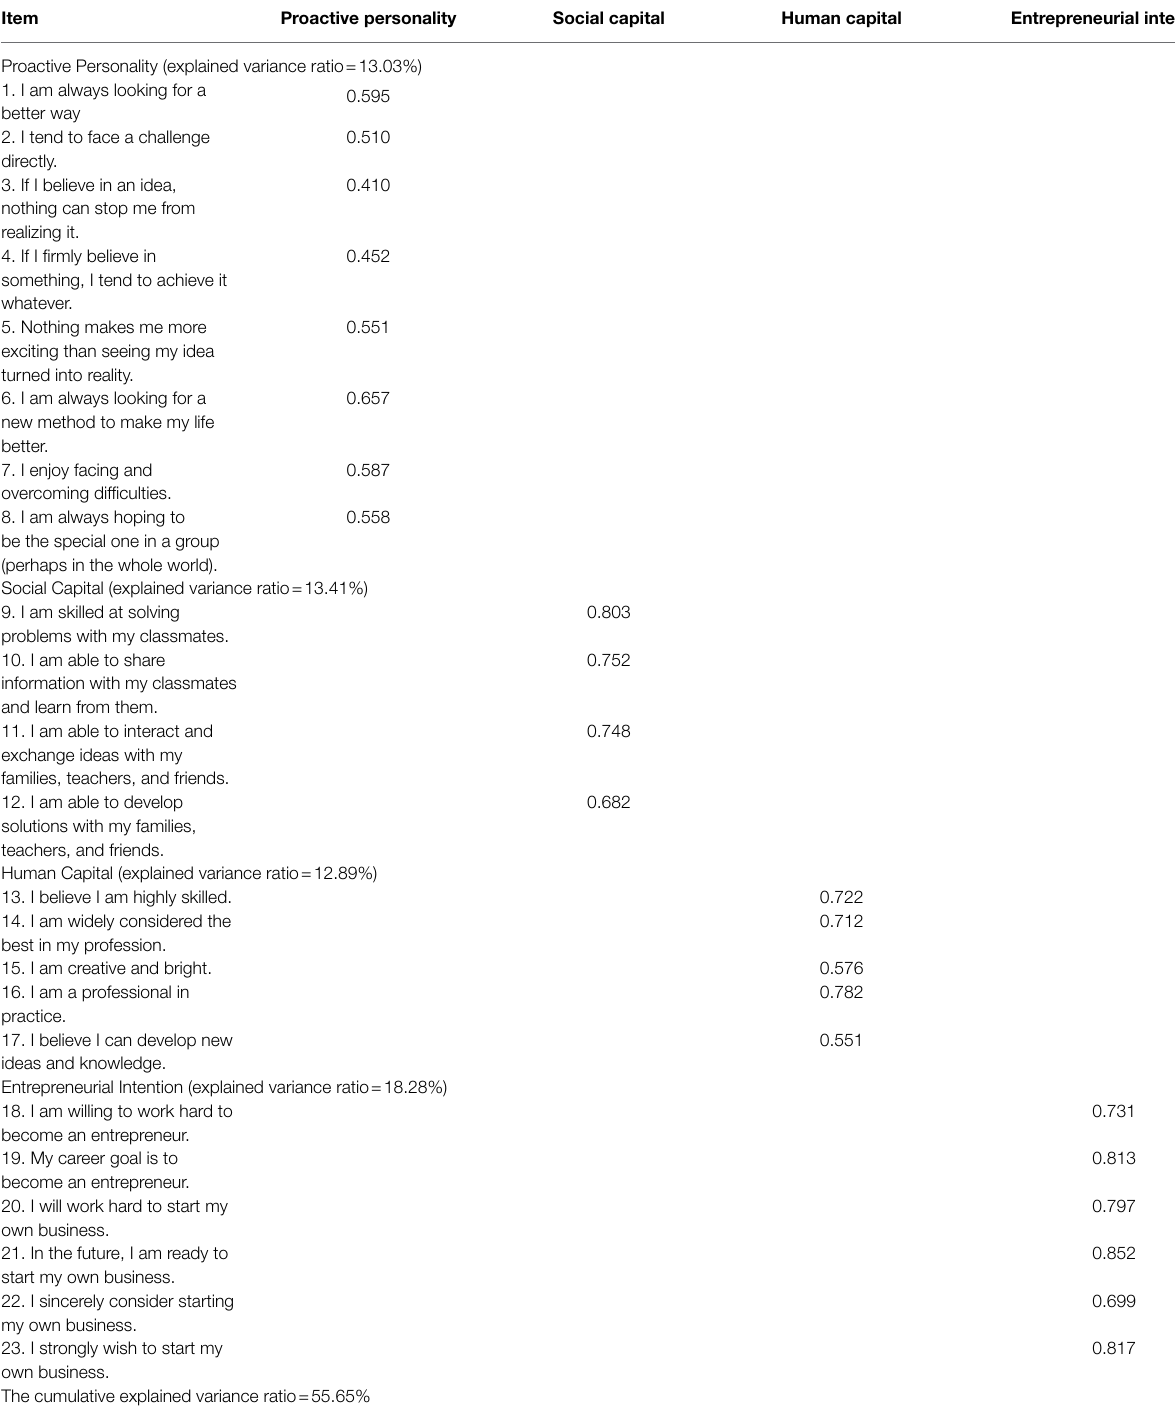
TABLE 1 | Summary of the Exploratory Factor Analysis. Item Proactive personality Social capital Human